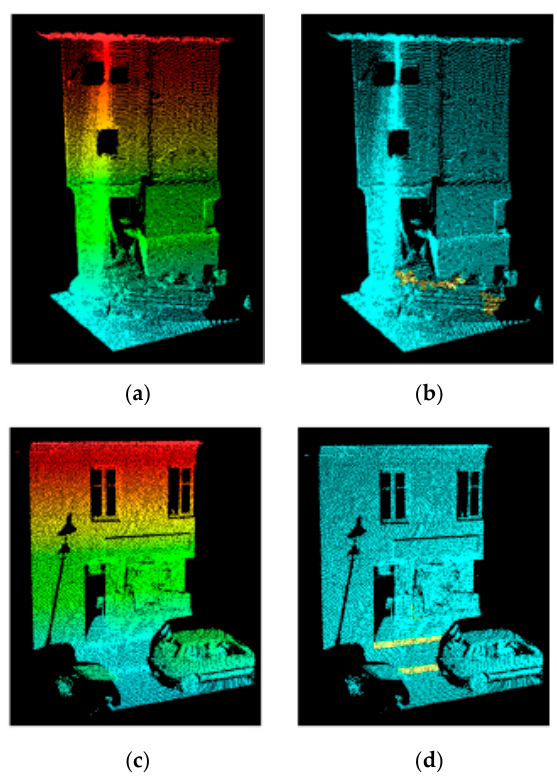
Figure 14. Two cases of false positives at Test Site 2. In both cases some elements with similar geometry to curbs, such as stair steps ( a and b ) or benches ( c and d ), are wrongly determined.